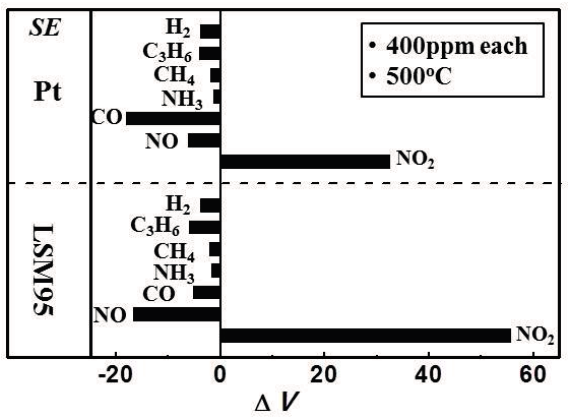
Figure 12. Cross-sensitivities of S-LSM95 and S-Pt to various gases (400 ppm) at 500 °C in the sample gas.